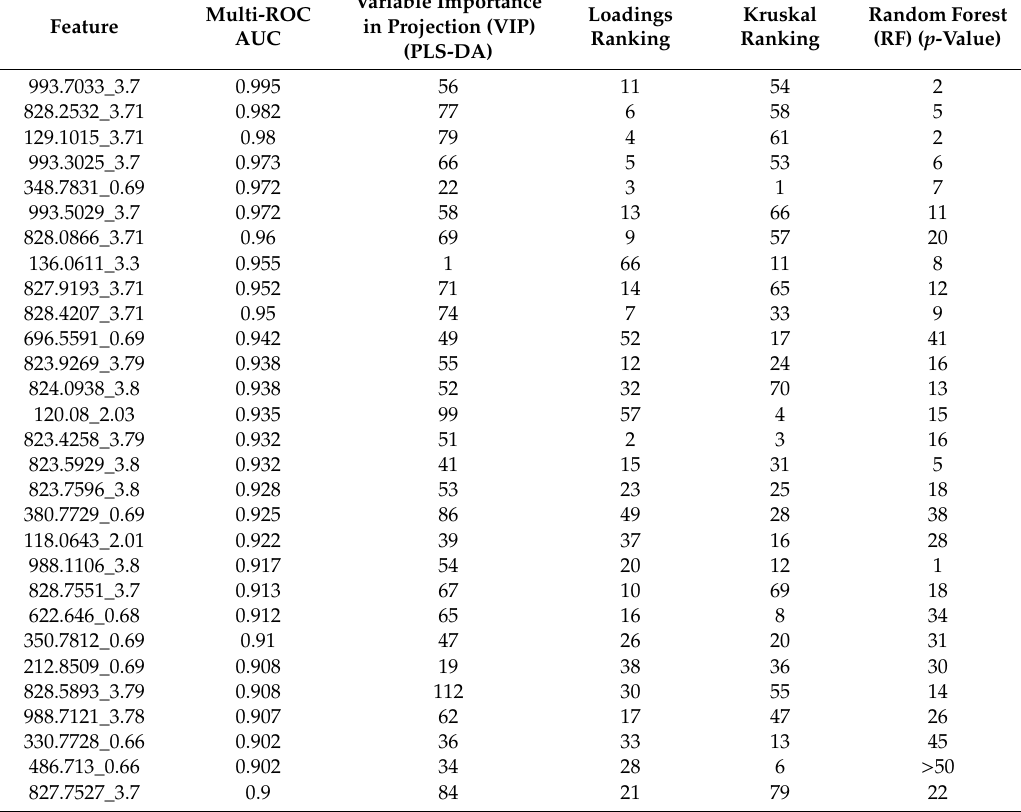
Table 2. MS features with multi-ROC AUC > 0.9 and their ranking, based on di ff erent multivariate approaches. Knowledge Discovery by Accuracy Maximization Analysis (KODAMA) loadings and Breiman’s Random-Forest (BF-R) classification exhibit better performance for the four-group UBC-member comparisons than the classical PLS-DA